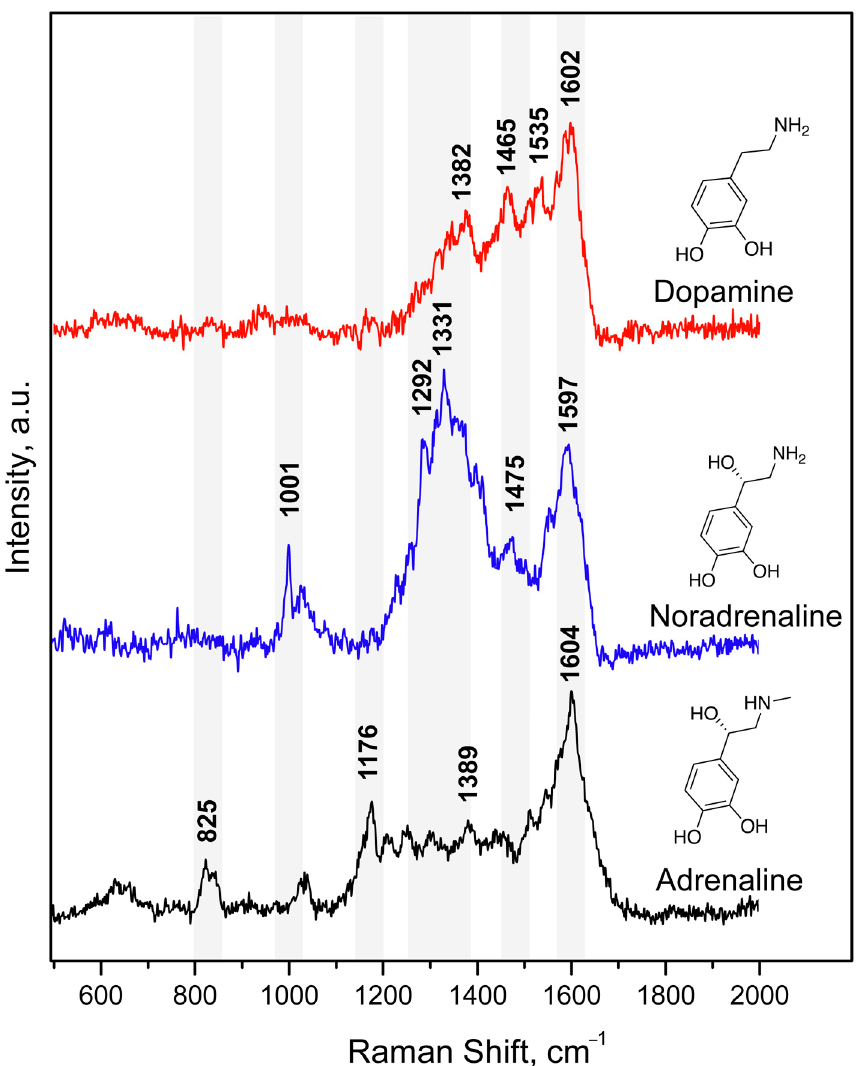
Figure 6. SERS spectra of the DA (0.1 mM), NA (0.1 mM), and AD (0.1 mM) applied onto the SERS substrate modified with Cu(II) ions and L 3 (1 mM) at 633 nm excitation laser